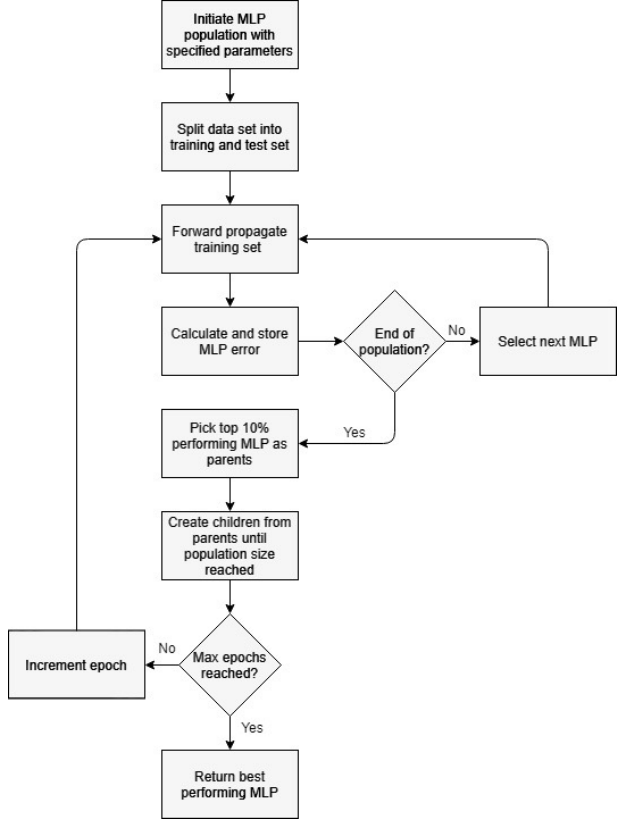
Figure 5. Genetic